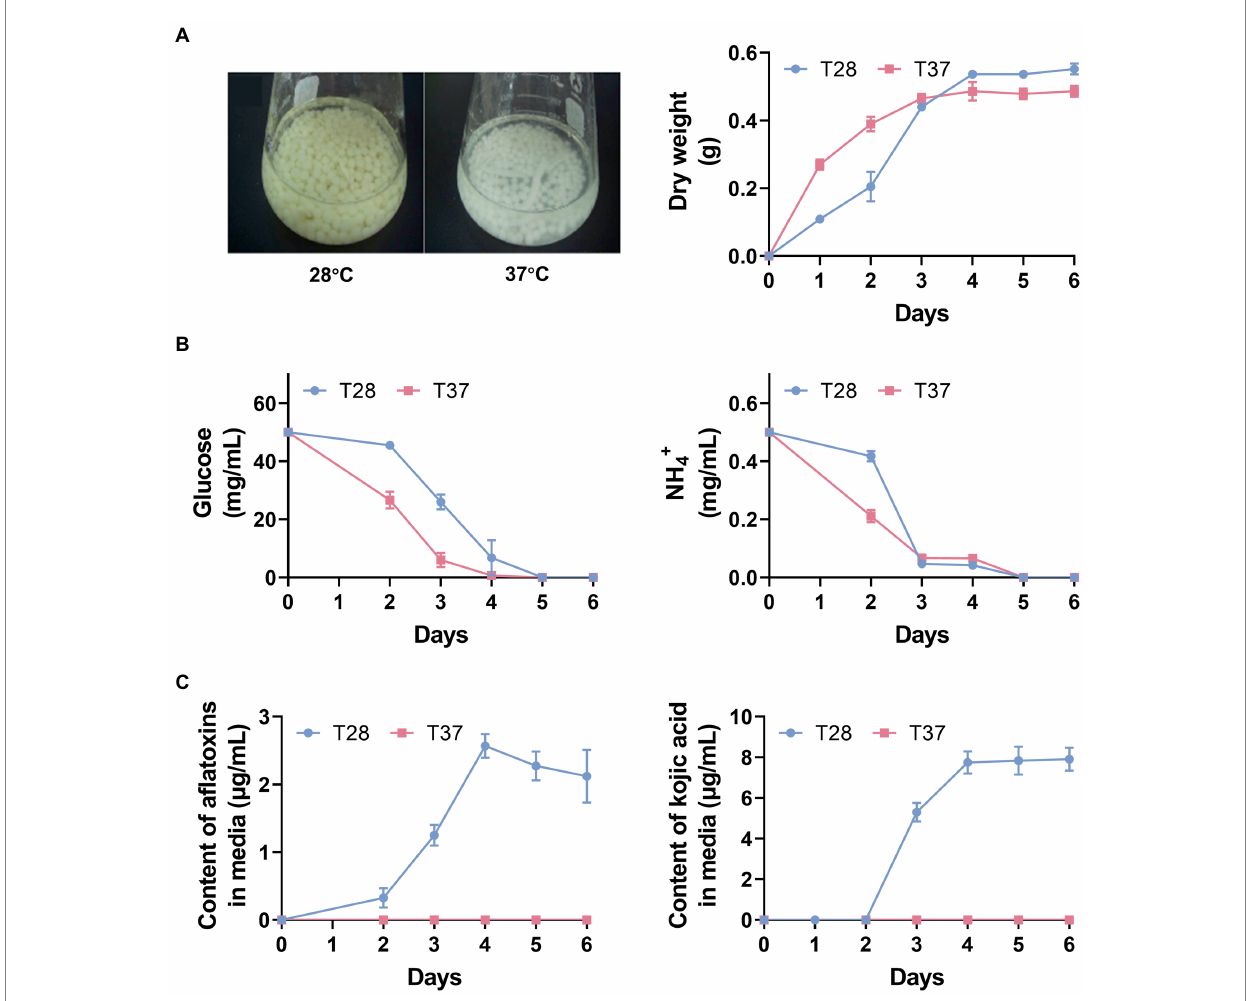
temperatures and days (Figure 4C). Similar to the metabolite profiles derived from GC–MS data, T37 samples over the growth stage were relatively dispersed compared to T28. The lipidome data obtained in the negative ion mode showed poor dispersion over the growth stage, but differences between temperatures were clearly distinguished (Figure 4D). 58 lipids, including PCs, PIs, PEs TGs, etc., significantly differentially accumulated between the T28 and T37 samples (Figure 4E). The up-and down-regulated lipids in the T37 samples contained various lipid classes, such as PCs and TGs, suggesting no significant correlation between the regulated lipid classes and temperature. However, cluster analysis of the differentially accumulated lipids revealed a unique pattern in their side chain compositions at different temperatures. Lipids with saturated fatty acid side chains (C16:0, C17:0, C18:0, etc.) were significantly up-regulated in T37 samples, while lipids with polyunsaturated fatty acid side chains (C18:2, C18:3, etc.) were significantly down-regulated. This changing pattern was similar across samples taken on days two to six. These results demonstrated that the composition of lipid side chains in A. flavus was greatly affected by